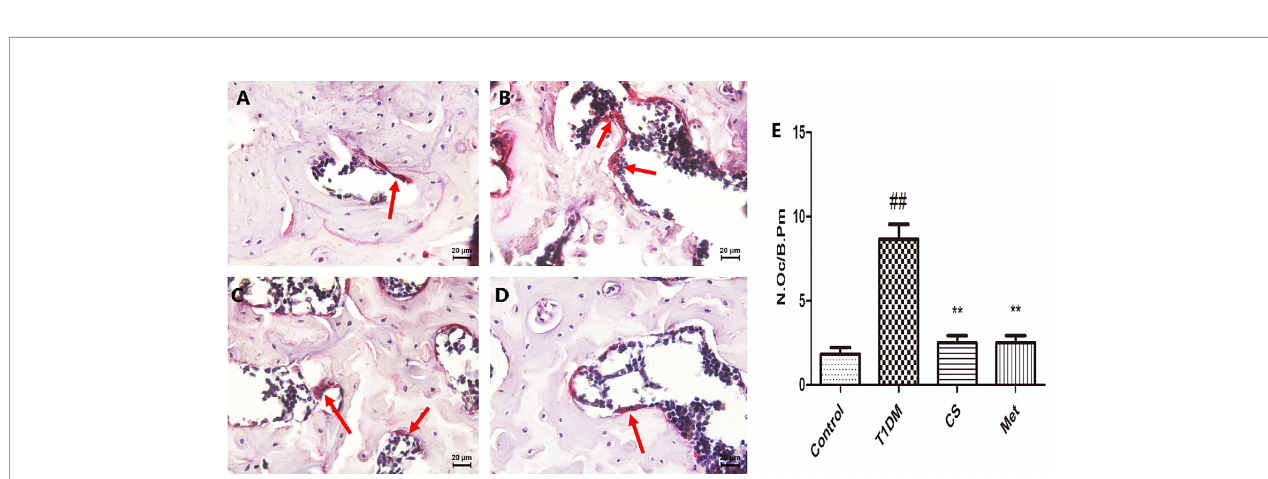
FIGURE 8 | The osteoclasts in femoral bone tissues of different groups at the end day of the 10th week. (A) The femoral bone tissues of control group rat. (B) The femoral bone tissues of diabetic group rat. (C) The femoral bone tissues of CS group rat. (D) The femoral bone tissues of Met group rat. (E) Number of osteoclasts per unit fi eld in different groups. Bone tissues were stained by TRACP method, osteoclasts are multinucleate cells, and the red arrows point to osteoclasts. ## indicates p < 0.01 compared with control. **indicates p < 0.01 compared with the diabetic group.